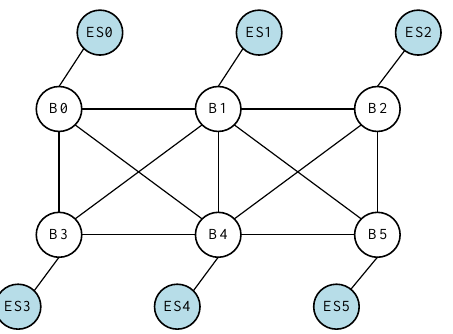
Figure 9. Topology 2, which is a partial mesh topology used in our cases.